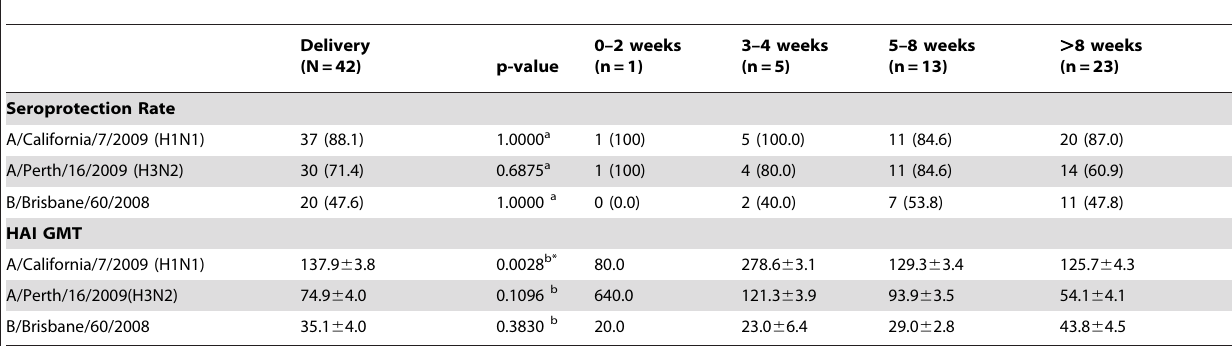
Table 4. Seroprotection rate and HAI GMT of cord blood